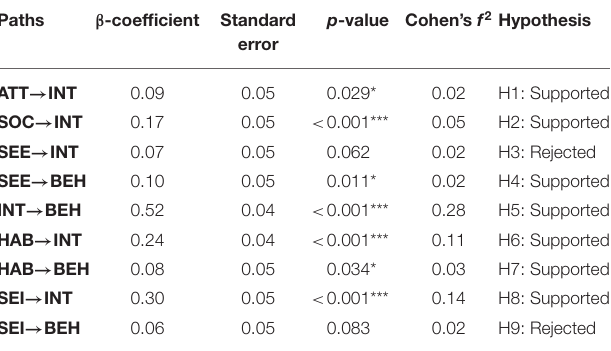
TABLE 2 | Structural relationship between the constructs and hypotheses’ status.